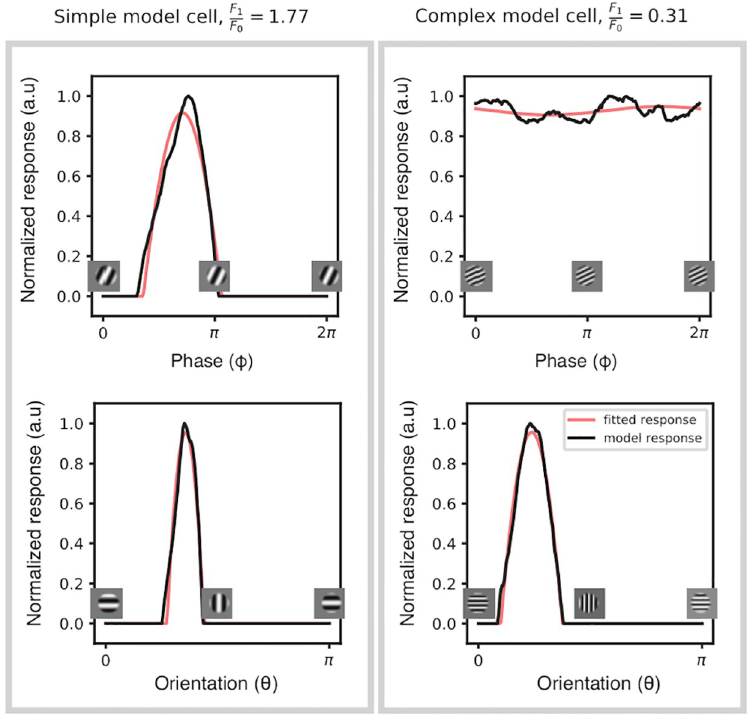
Fig 2. Response of simple-like and complex-like model neurons. Example of two model neurons exhibiting a simple ( left ) and complex ( right ) behavior. The black lines indicate the model neuron’s response when its receptive field contains a drifting ( top ) or rotating ( bottom ) stimulus; the red lines indicate the response modeled according to a half- rectified sinusoidal model as in [39]. The modulation ratio, F 1 , is greater than 1 for simple neurons that are tuned to a F 0 specific phase. A complex response, that is partially or completely independent to phase, is quantified by a low modulation ratio (less than 1). Importantly, both neurons remain tuned to orientation.